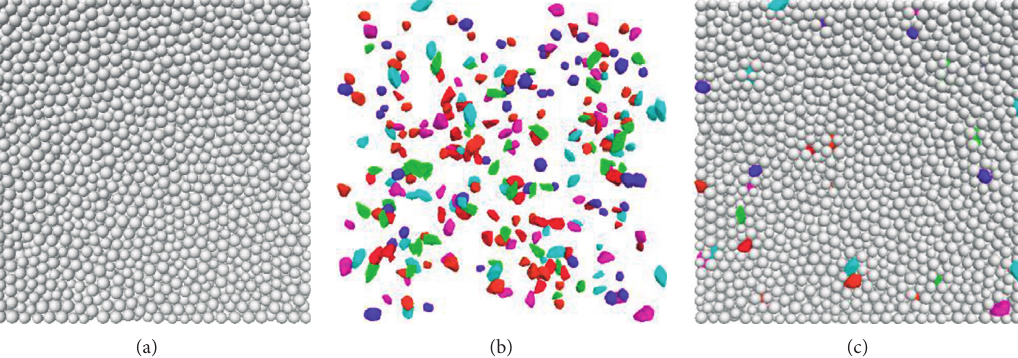
Figure 4: DEM numerical sample model of coarse and fine particle mixing. (a) Pure fine-grained soil. (b) Stone particle clump. (c) Coarse and fine particle mixing.